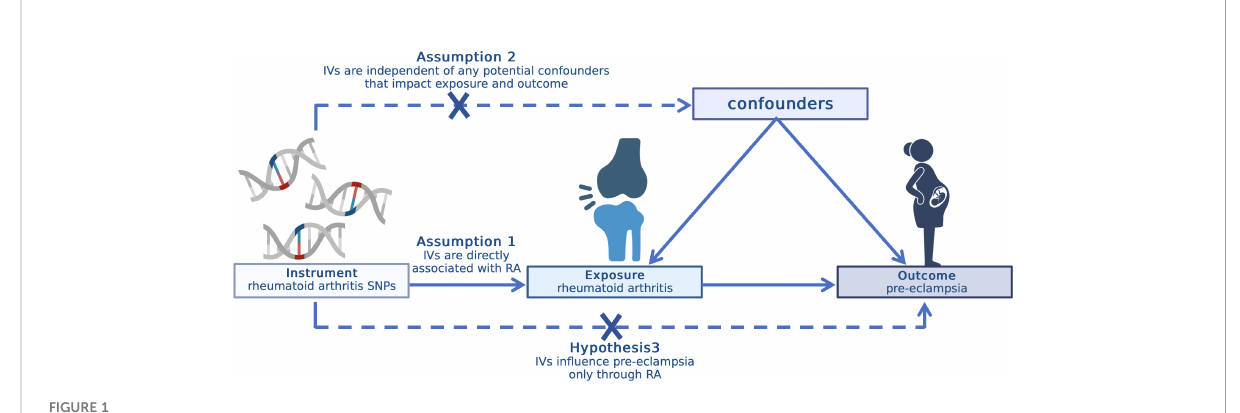
FIGURE 1 Overview of the MR design. MR, mendelian